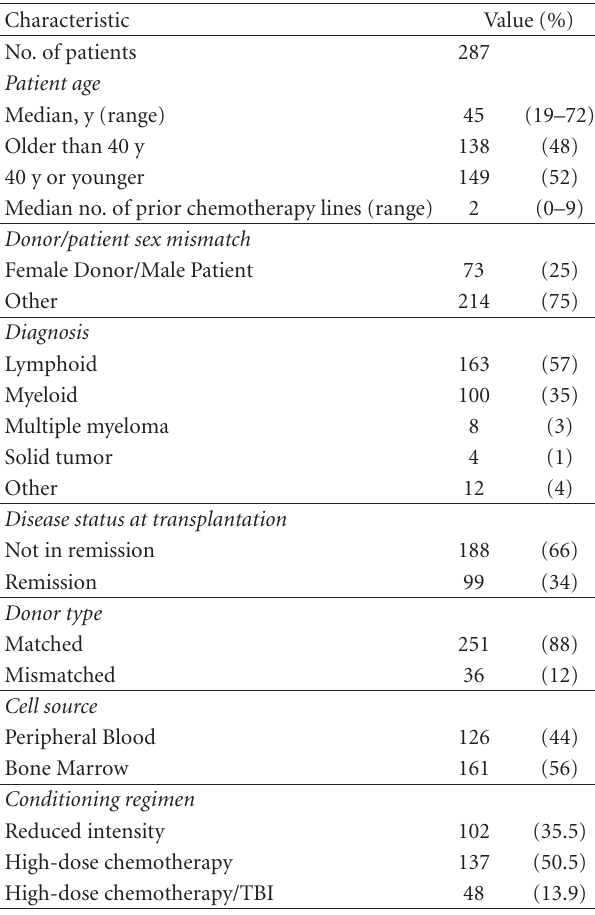
Table 1: Patients and transplant